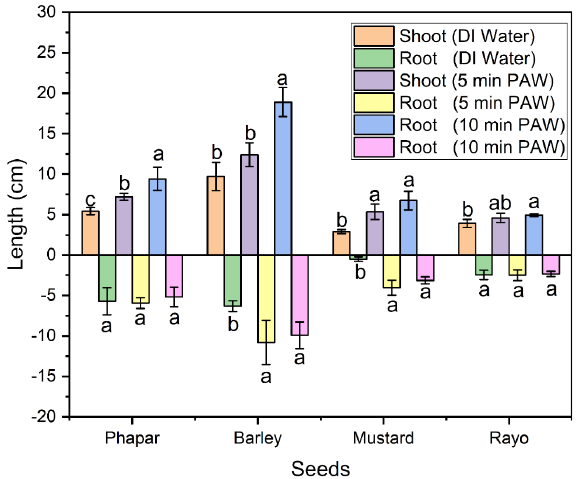
Figure 13. Shoot and root length of seedlings irrigated with DI water and PAW. Different letters (a–c) indicate significant differences at p < 0.05 level among all treatments as determined by Tukey’s multiple comparison test.